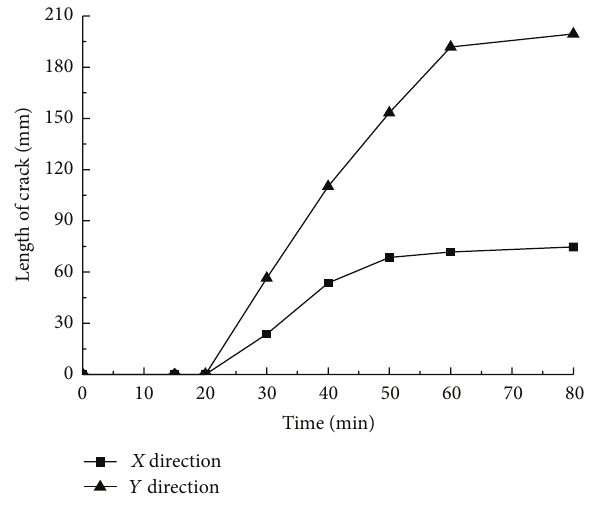
Figure 6: The relation curves between the expansion lengths of cracks A and B and time.